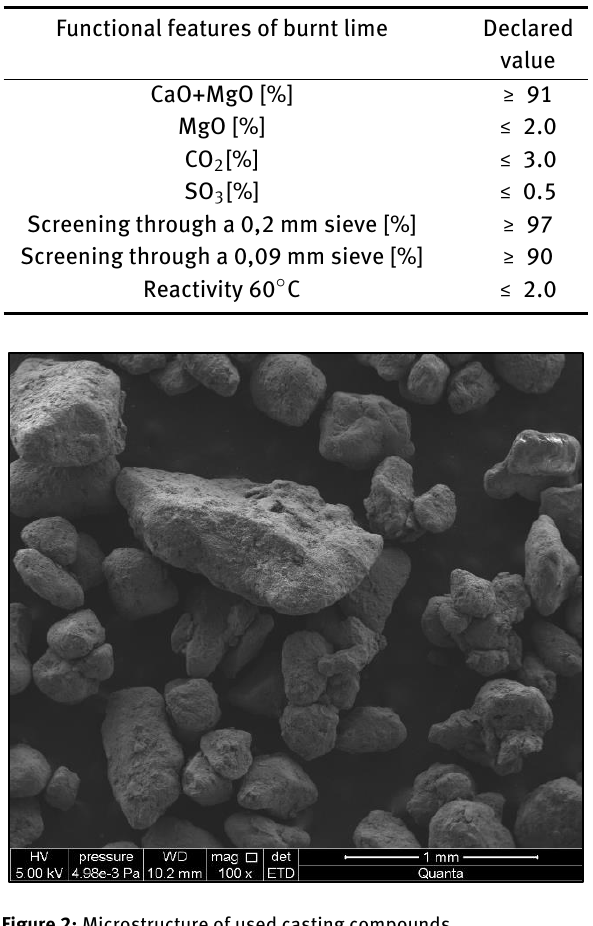
Figure 2: Microstructure of used casting compounds.